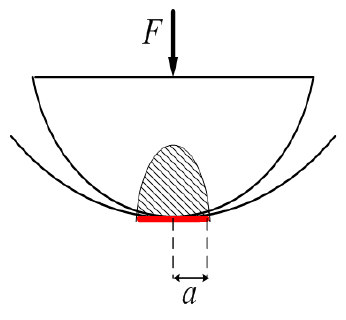
Figure 3. Contact surface status.